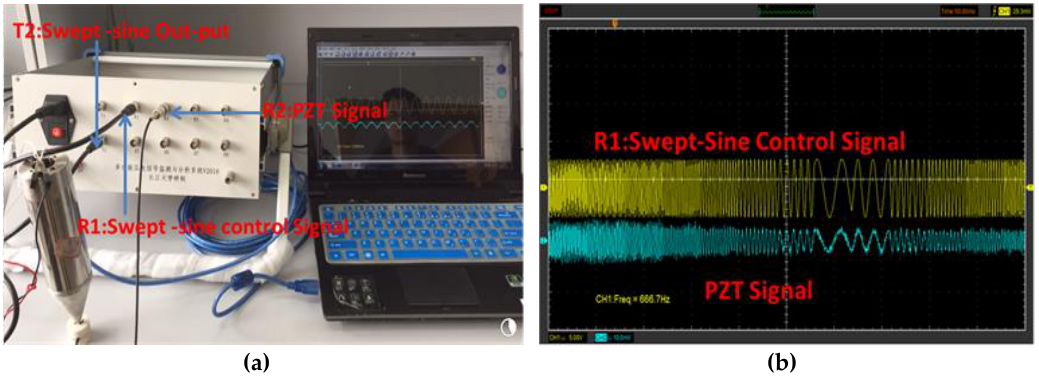
Figure 7. Sweep sine signal test. (a) Instrument setup for generating sweep signal; (b) Generated sweep signal waveform.